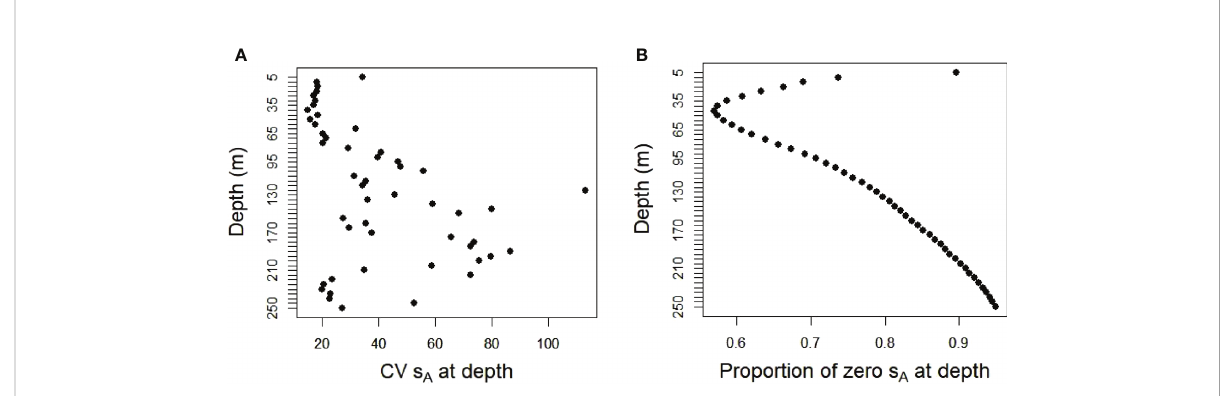
(Figure 7). The generally lower (better) scores from Cape Shirreff for the equivalent number of gliders and maximum dive depth indicated the Cape Shirreff gliders estimated the true s A better than those sampling Brans fi eld Strait, likely because either because Cape Shirreff had nearly twice the trackline length available for glider sampling or because Cape Shirreff had a less zero-in fl ated distribution (Supplementary Table S1), or both.